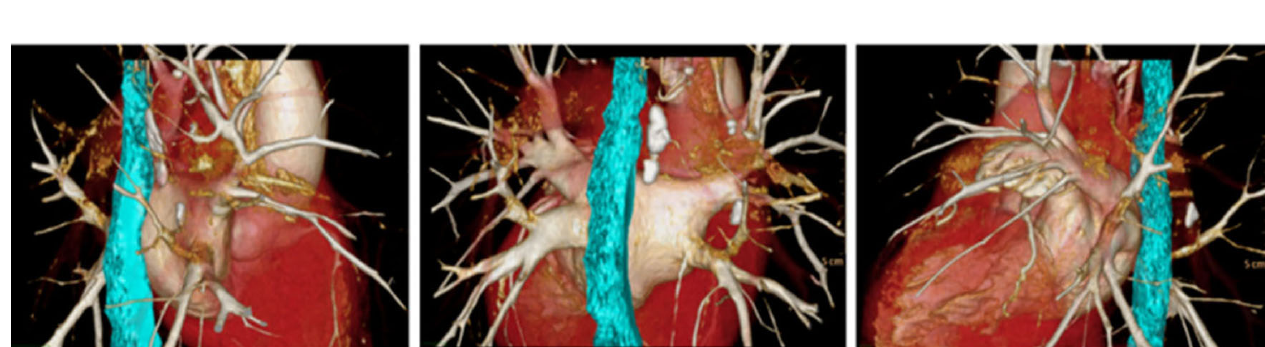
Fig. 1 - Cardiac computed tomography with esophagus visualization in RAO, PA and LAO, respectively, from left to right. There is a large contact area between the esophagus and the left atrium. This anatomical relationship can easily explain the risk of thermal injury of the esophagus during endocardial left atrial ablations. RAO=right anterior oblique; PA=postero-anterior; LAO=left anterior oblique